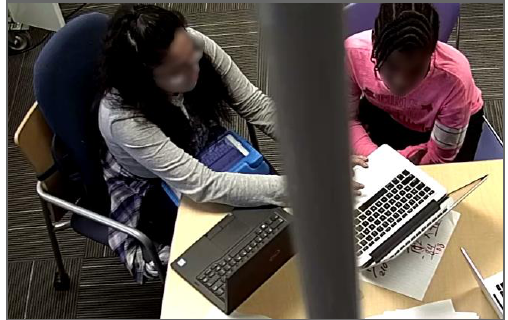
Figure 3. Amalya and Anisha working in TinkerCAD 3D modelling software.